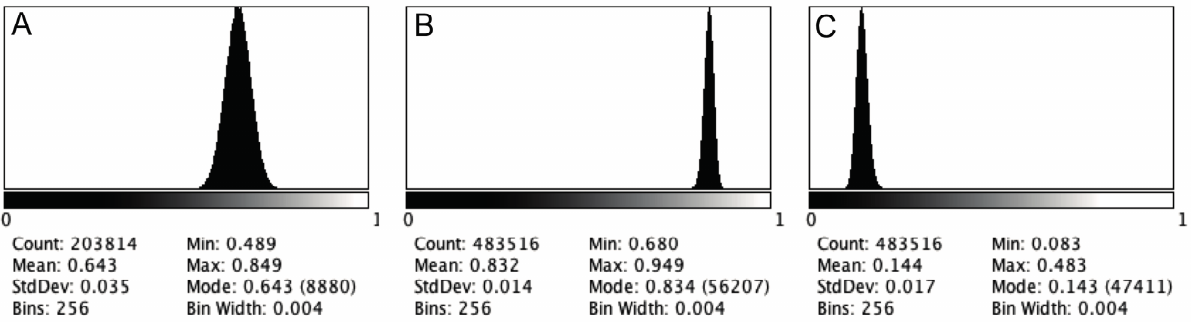
Figure 8. Examples of spectral coherence histograms obtained on open sea areas with different processing settings: ( A ) 40 MHz sub-bands with 2/3 overlapping, ( B ) 100 MHz sub-bands with ~82% overlapping, ( C ) 40 MHz sub-bands with no